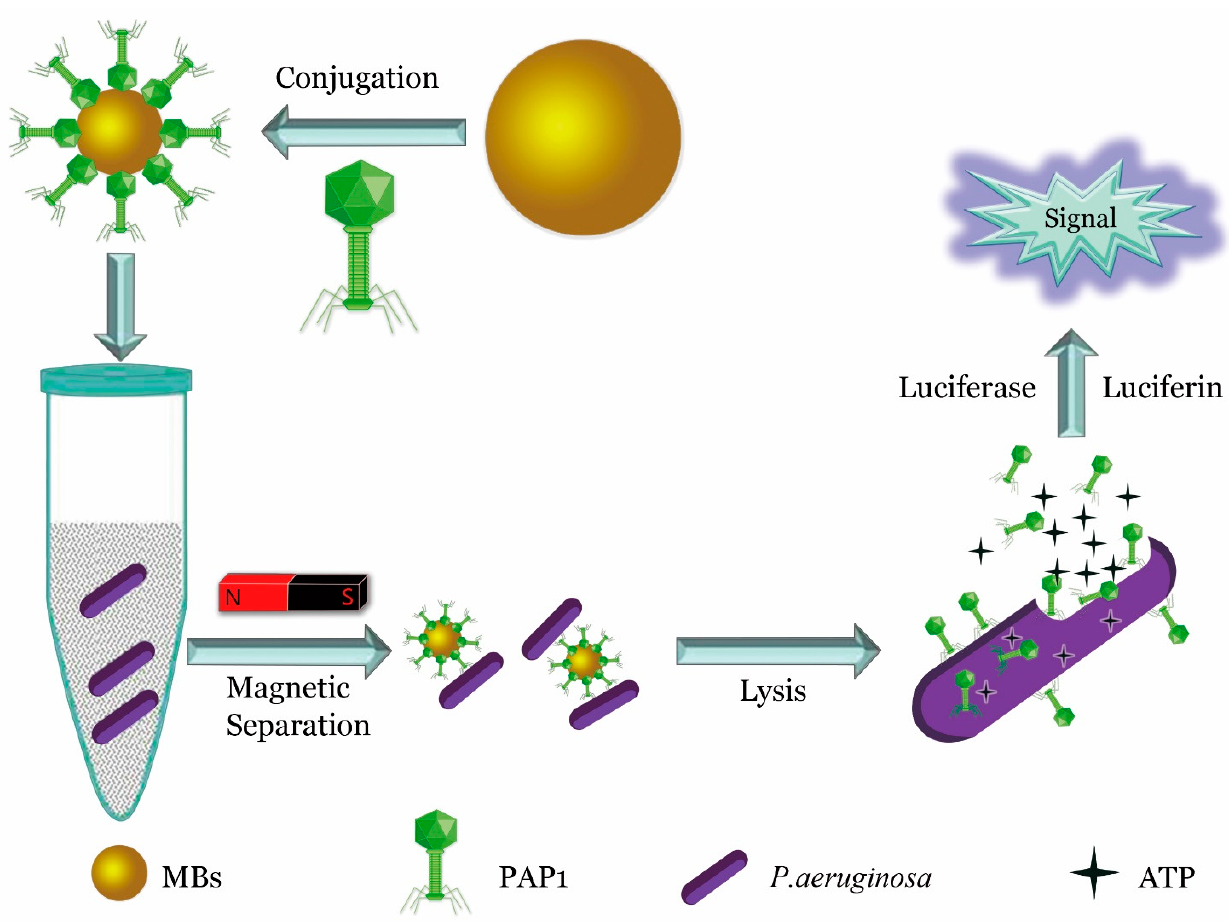
Figure 2. Quantitative detection of P. aeruginosa using specific phage. Highly specific fusion phage and magnetic bead assembly to construct a specific probe for enrichment of P. aeruginosa , and release of ATP from the bacteria through phage lysis. ATP was quan- tified to determine the presence and quantity of P. aeruginosa [25].